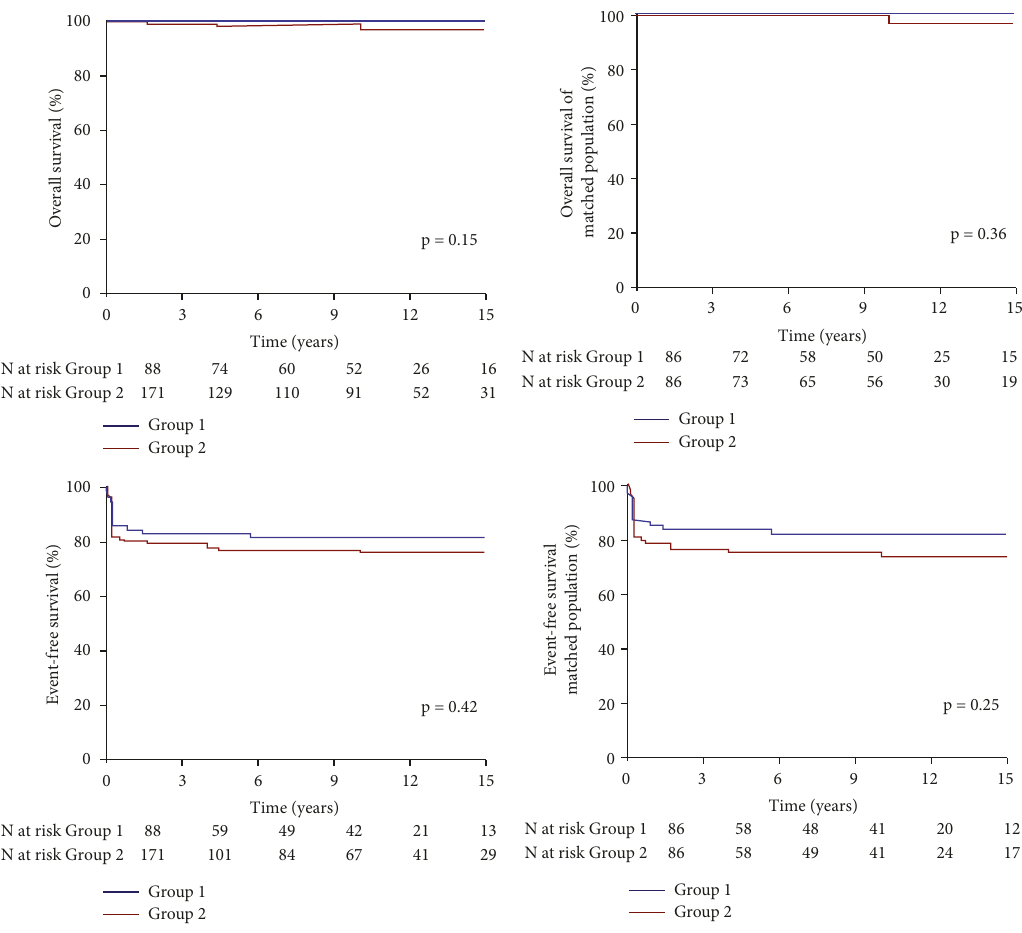
Figure 3: Kaplan–meier analysis showing the comparison between groups of the overall and event-free survival in the total cohort and in the matched population. Group 1, Group short; Group 2, Group long; ATT, antithrombotic